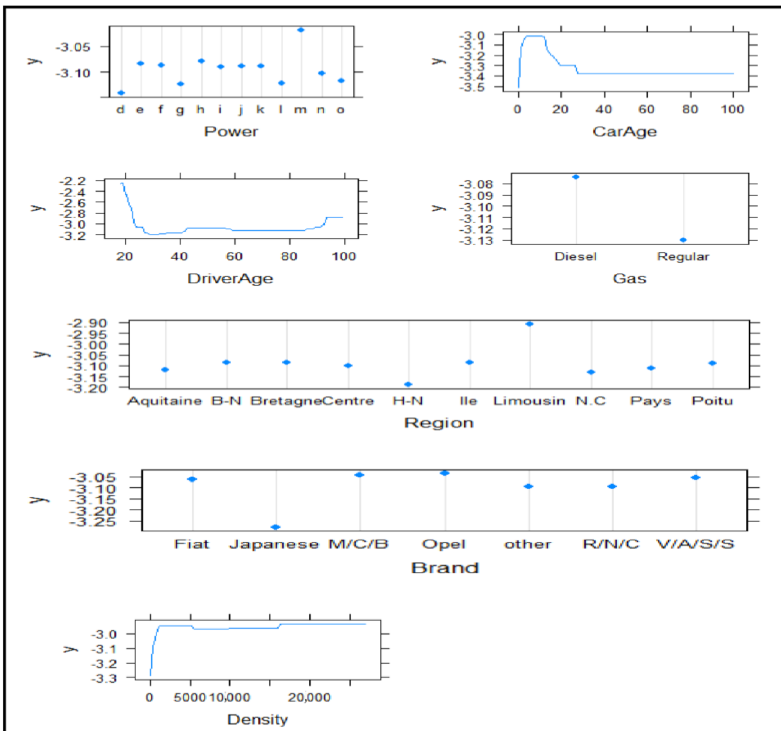
Figure 3. Partial dependence plots from the Boosting Tree. Abbreviations: B-N (Basse-Normandie), Ile (Ile-de-France), N.C. (Nord-Pas-de-Calais), Pays (Pays-de-la-Loire), Poitu (Poitou-Charentes), Japanese (Japanese (except Nissan) or Korean), M/C/B (Mercedes, Chrysler or BMW), V/A/S/S (Volkswagen, Audi, Skoda or Seat), Opel (Opel, General Motors or